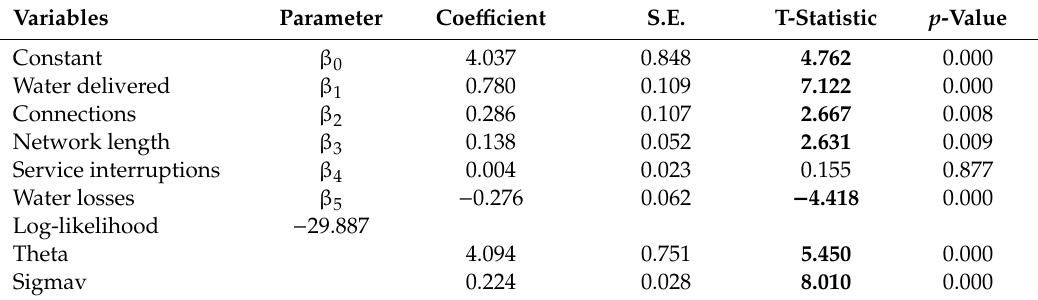
Table A3. Estimates of the cost frontier model: worst